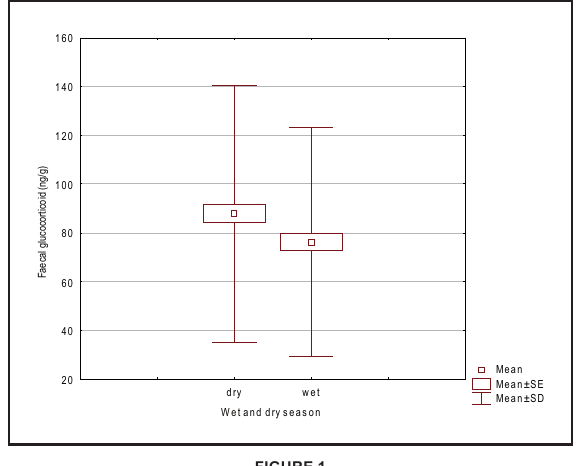
Figure 1 Box-plots of grouped concentrations of immunoreactive faecal glucocorticoid metabolites (ng/g) for free-ranging family herds of elephants in KNP in the dry and wet seasons from May 2002 to August 2005.